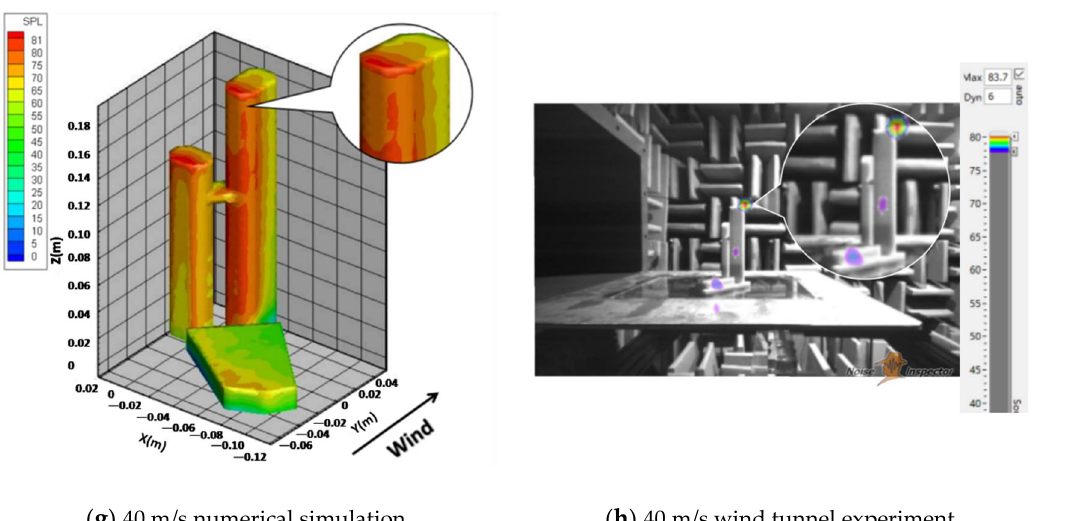
Figure 11. Comparison of experimental and simulated sound source localization at the wind angle of 270°.